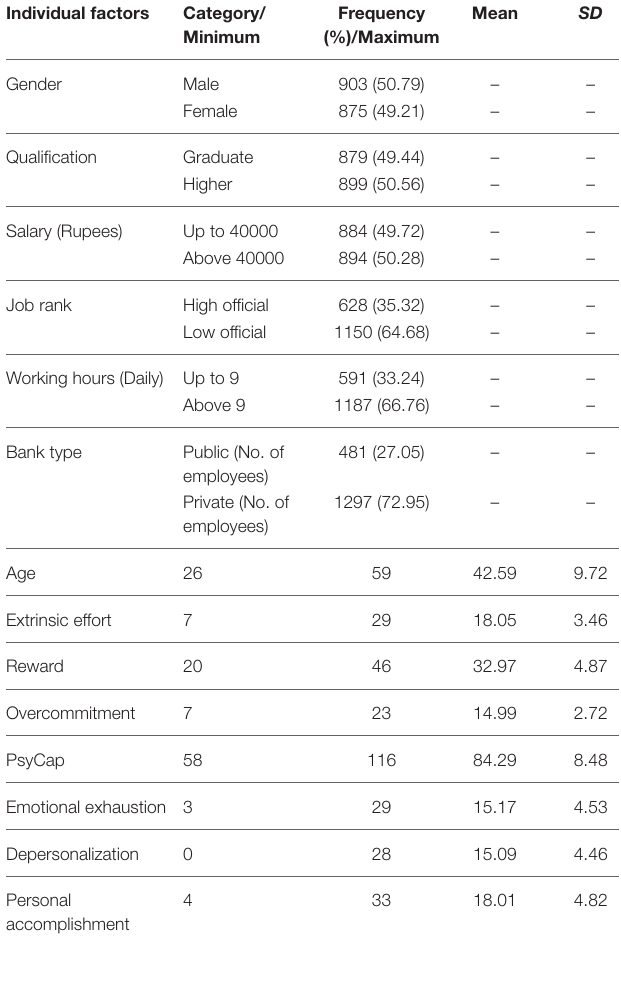
TABLE 1 | Descriptive statistics of all variables.